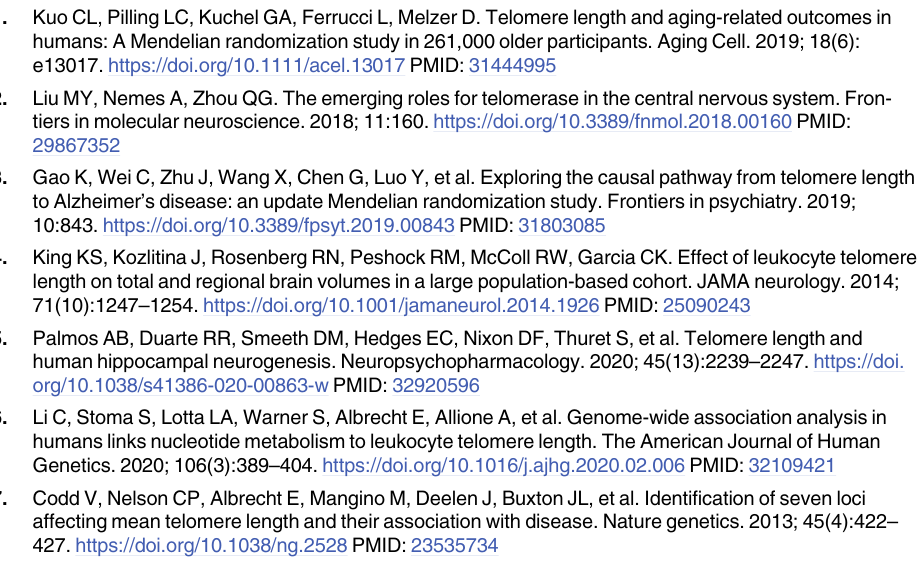
S1 Table. Full list of all MR results. S2 Table. Information on SNPs and their selected proxies for the MR